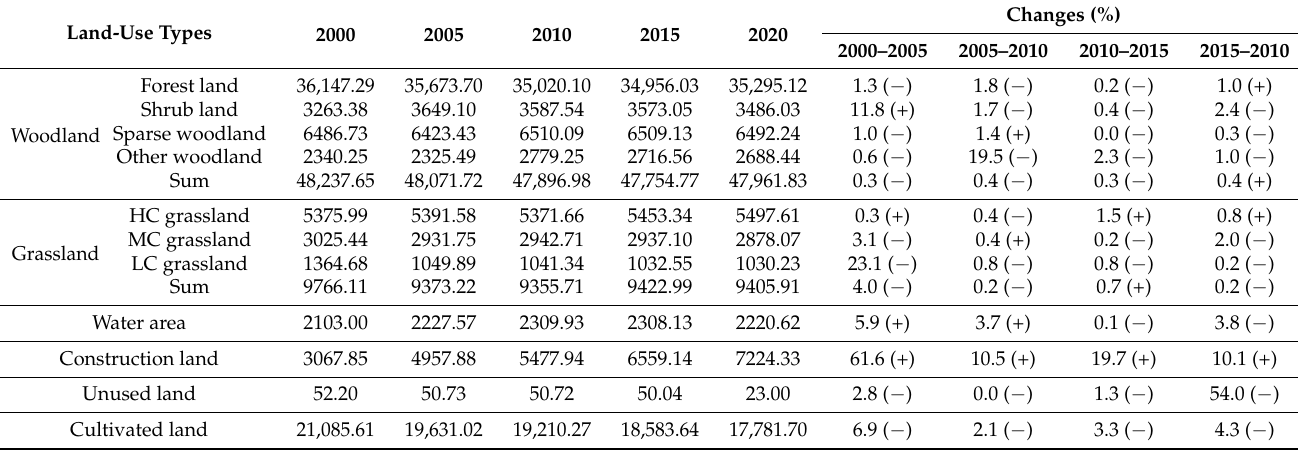
Table 3. Changes of different land-use types in coastal cities of southeast China over the past 20 years (km 2 ). HC, MC and LC grassland are high-, moderate-, and low-coverage grasslands. (+) and ( − ) represent the increase and decrease in green space area across adjacent five years, respectively.